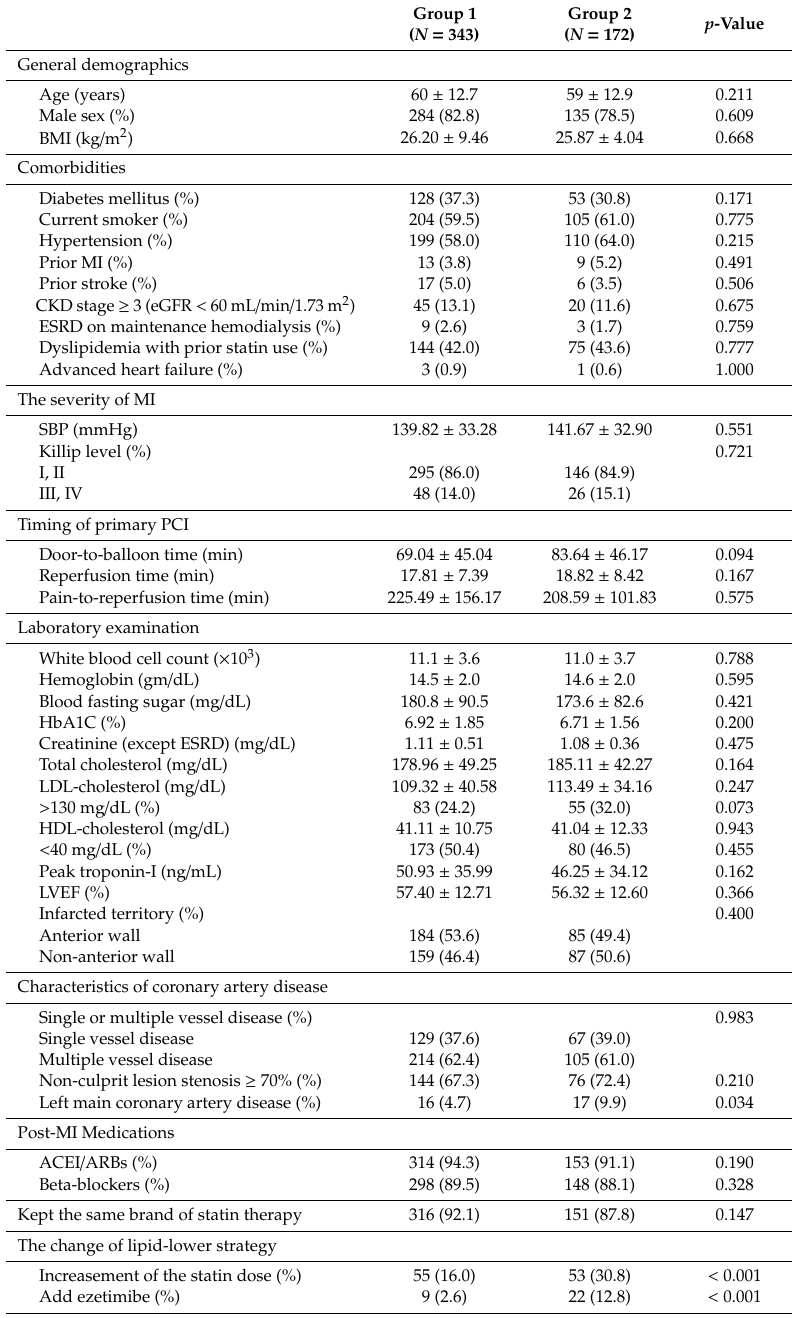
Table 1. Baseline characteristics of study